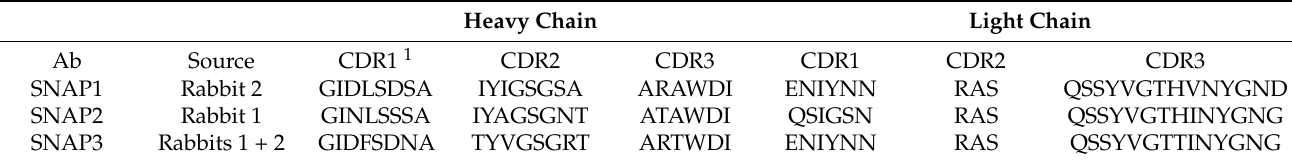
Table 1. Amino acid sequences of HCDRs and